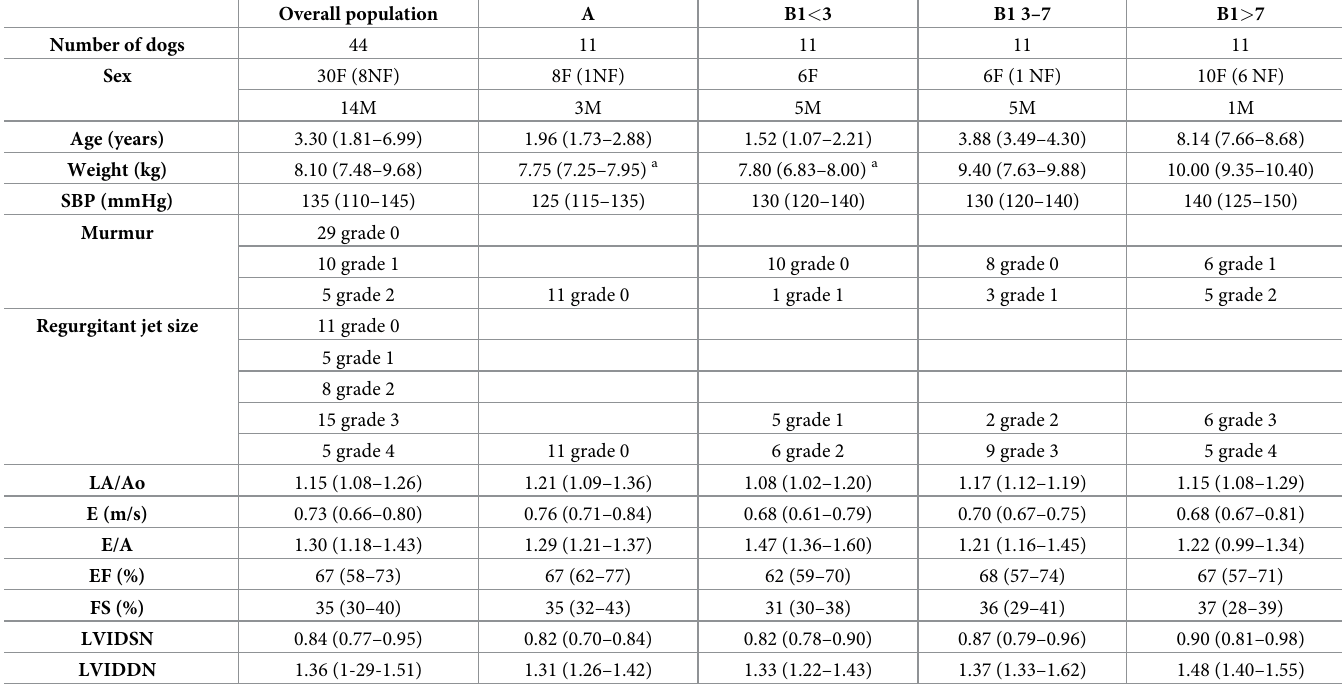
Table 1. Clinical and echocardiographic data of all included CKCSs divided according to the ACVIM classification scheme and age at the time of the MMVD diag- nosis for subjects belonging to ACVIM stage B1. Overall population A B1 <